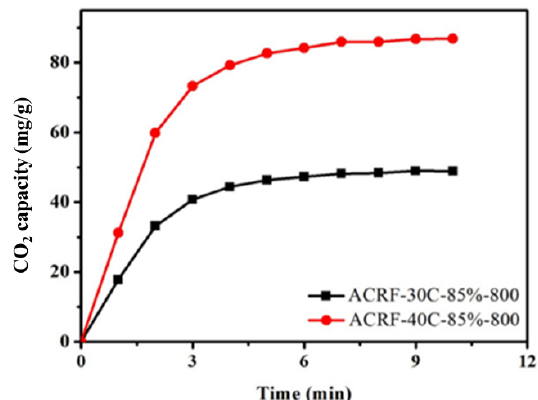
Figure 8. Comparison of the CO 2 adsorption kinetics of ACRF-40C-85%-800 and ACRF-30C-85%-